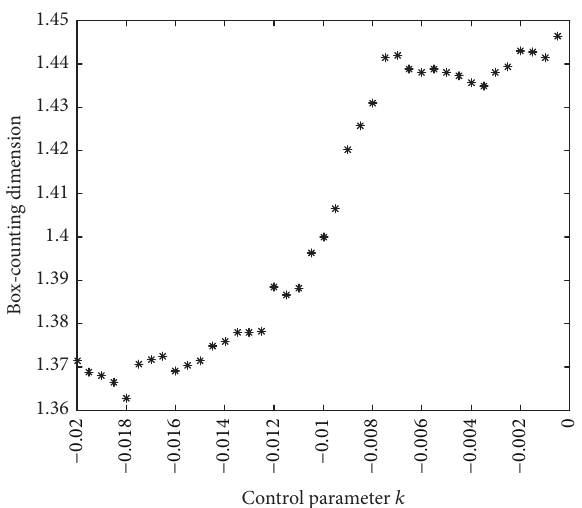
Figure 9: The change of box-counting dimensions of the Julia sets of the controlled system when 𝑘 is from − 0.02 to − 0.0005.